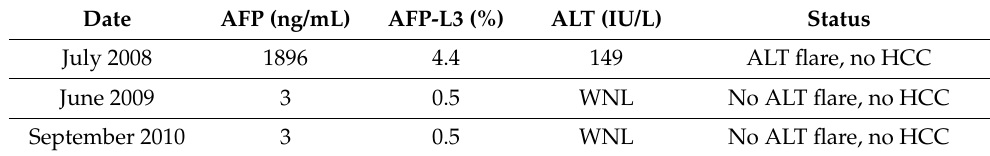
Table 1. Case 1. AFP, %L3, and ALT during each following year after initial elevation in